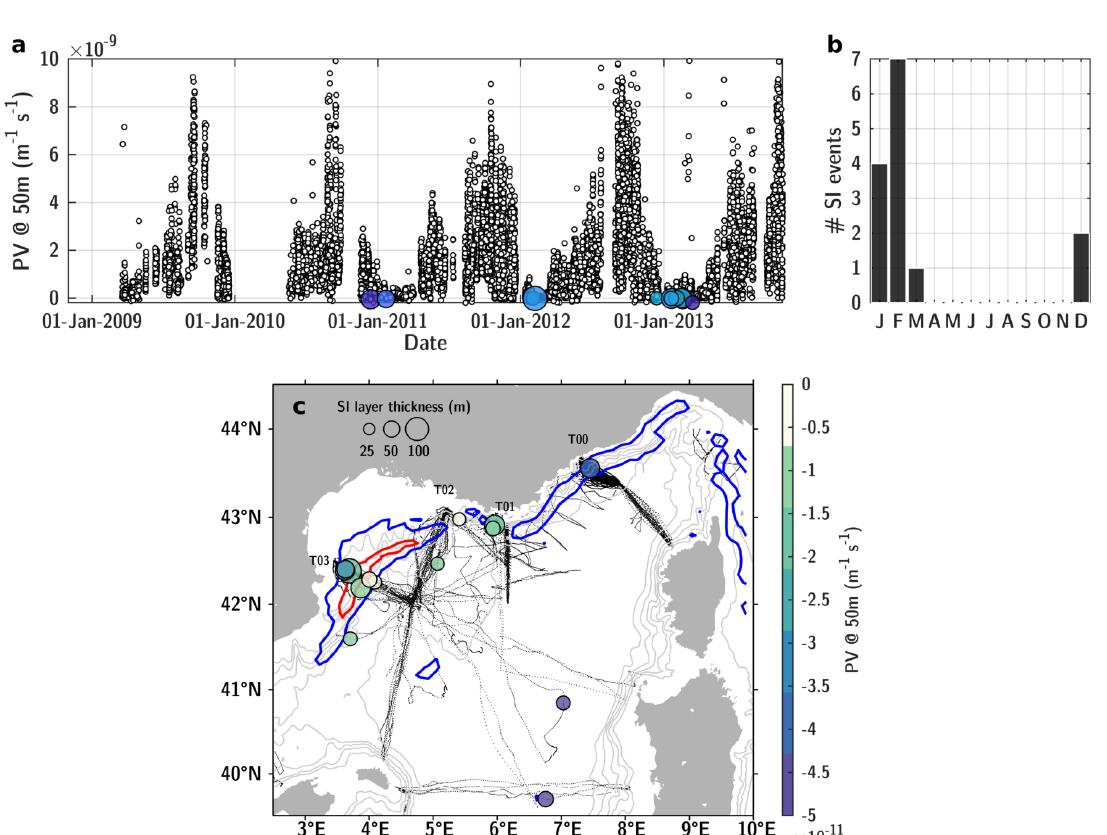
Figure 9. ( a ) Time series of PV observed by gliders in the study area. The colored dots corresponds to SI events. ( b ) Monthly histogram of the number of observed SI events. ( c ) Maps of SI events with gray dots showing all glider profiles. SI events are represented by a dot color-coded by the observed mean negative PV at 50m and whose size is proportional to the depth of the SI layer. The blue (resp. red) contour shows where the number of days prone to SI in the model exceeds 10 (resp. 20 days). Light gray contours represent isobaths every